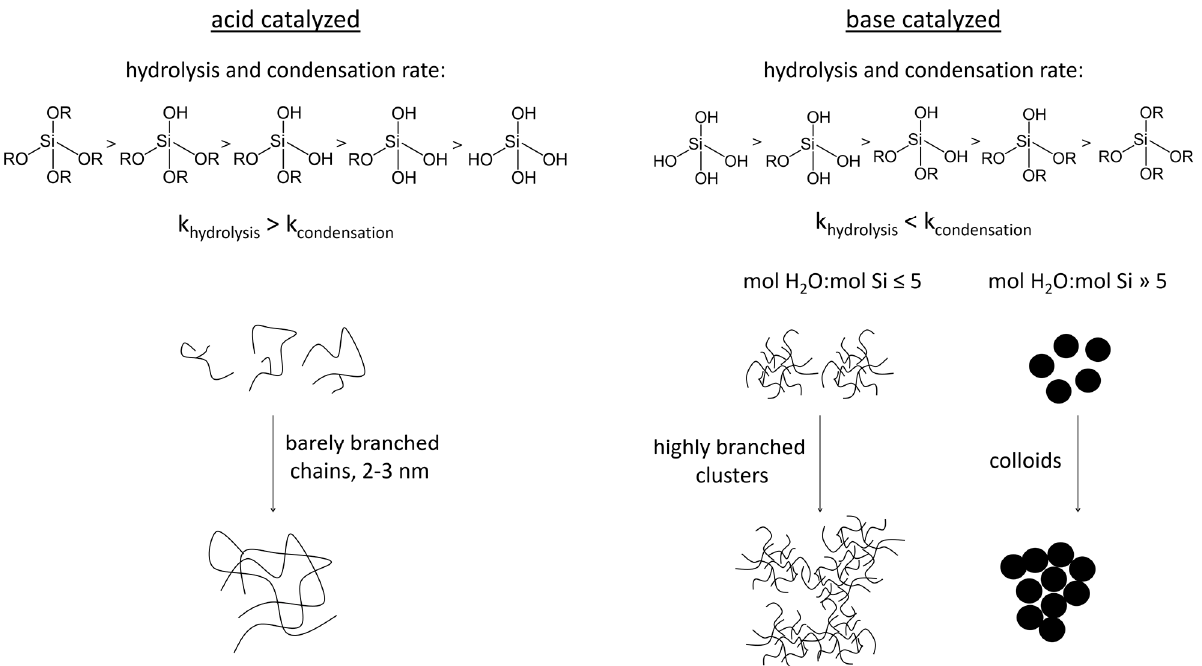
Figure 1. Schematic presentation of hydrolysis and condensation of alkoxysilanes under acidic and alkaline conditions, modified from [58,60,61,63].